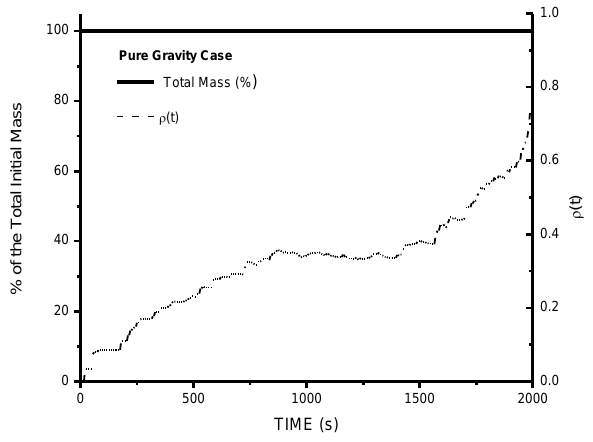
Fig. 3. Same as Fig. 2 but for the pure gravity case. Fig. 3.Same as Fig. 2 but for the pure gravity case.